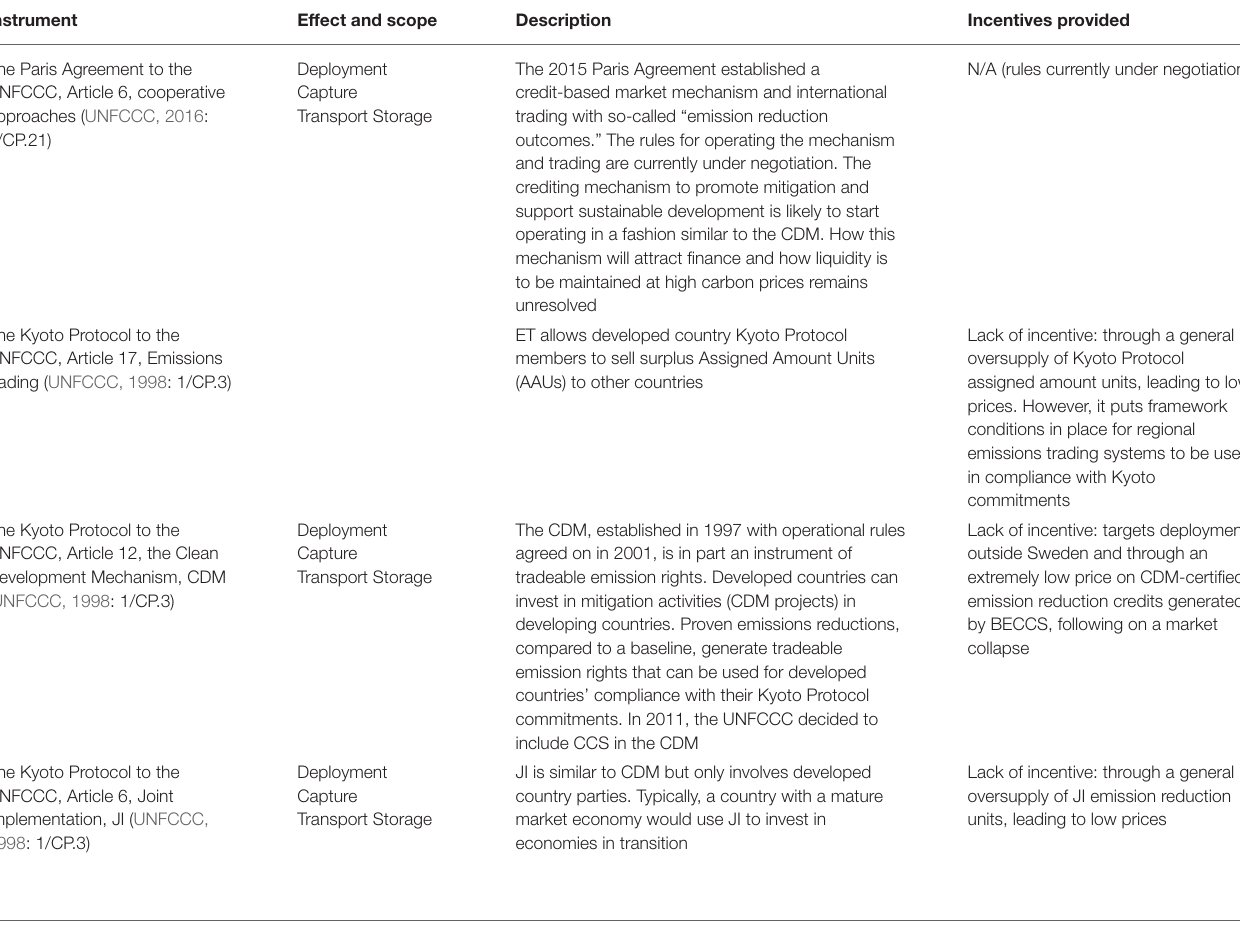
TABLE 2 | International (UN and regional multilateral) economic policy instruments of direct relevance to BECCS RDD&D in Sweden, in descending order of significance.